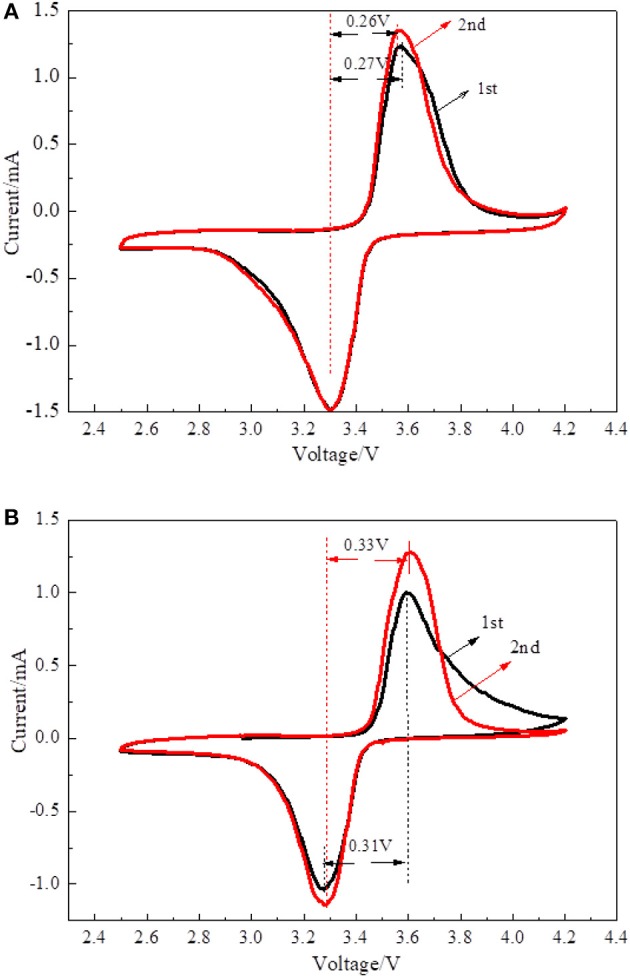
Cyclic voltammetry curves of LiFePO4/graphene (A) and LiFePO4/C (B) composites.